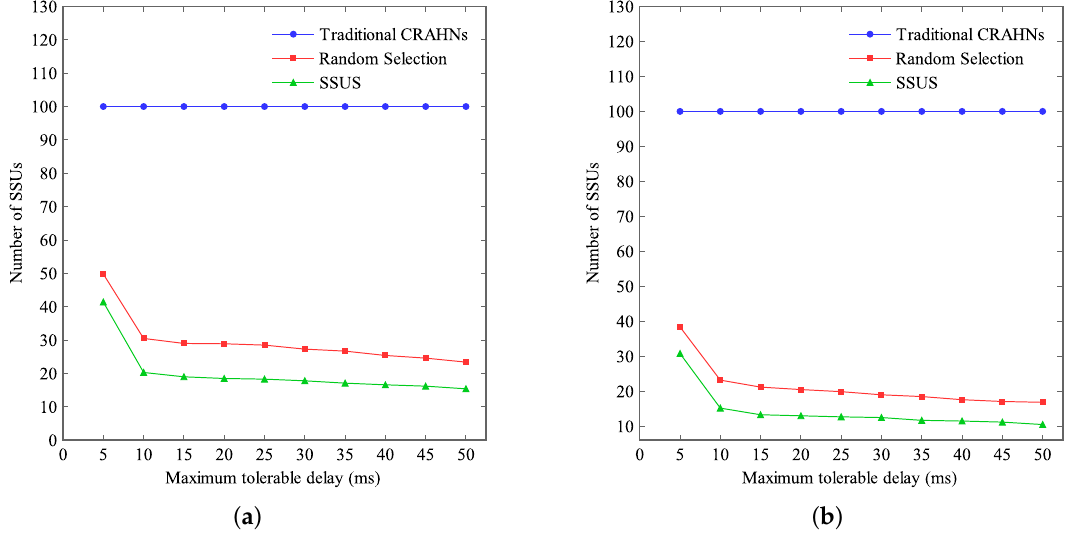
Figure 5. Number of SSUs vs. t δ . ( a ) Network size is 100 × 100 m 2 , ( b ) Network size is 60 × 60 m 2